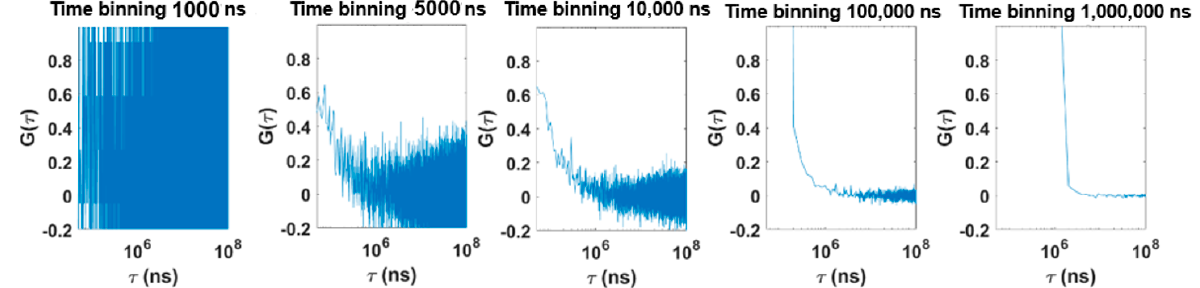
Figure 4. The effect of time binning in the range 10 3 –10 6 ns when performing autocorrelation on photon count data acquired from Rhodamine B solution at a concentration of 10 nM. The data was obtained from red channel (580/150 nm) at 800 nm excitation wavelength, 25 mW excitation intensity using 63× (NA 1.2) objective lens.